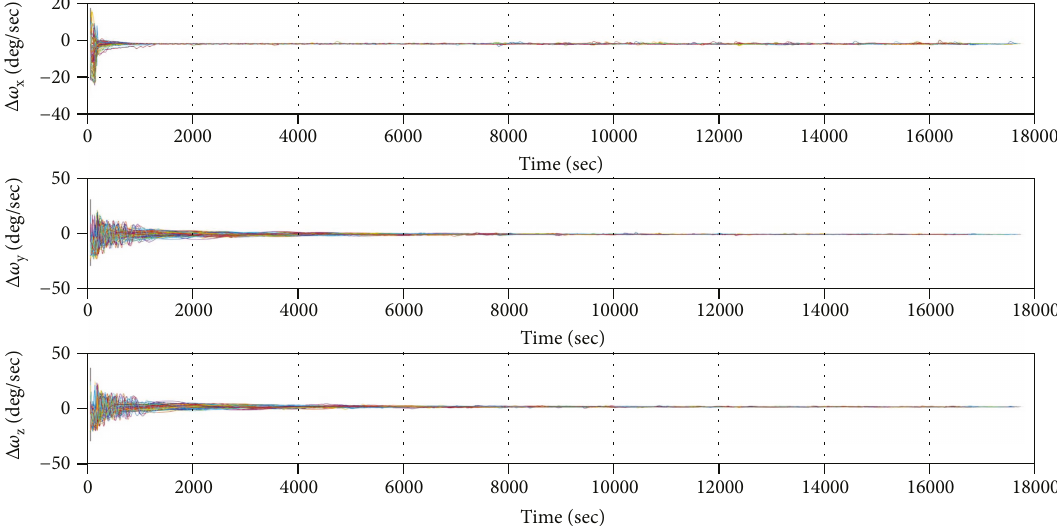
Figure 10: Time behavior of the measurement errors ( Δ ω uncertainties on the deployment conditions and on the inertial properties of the